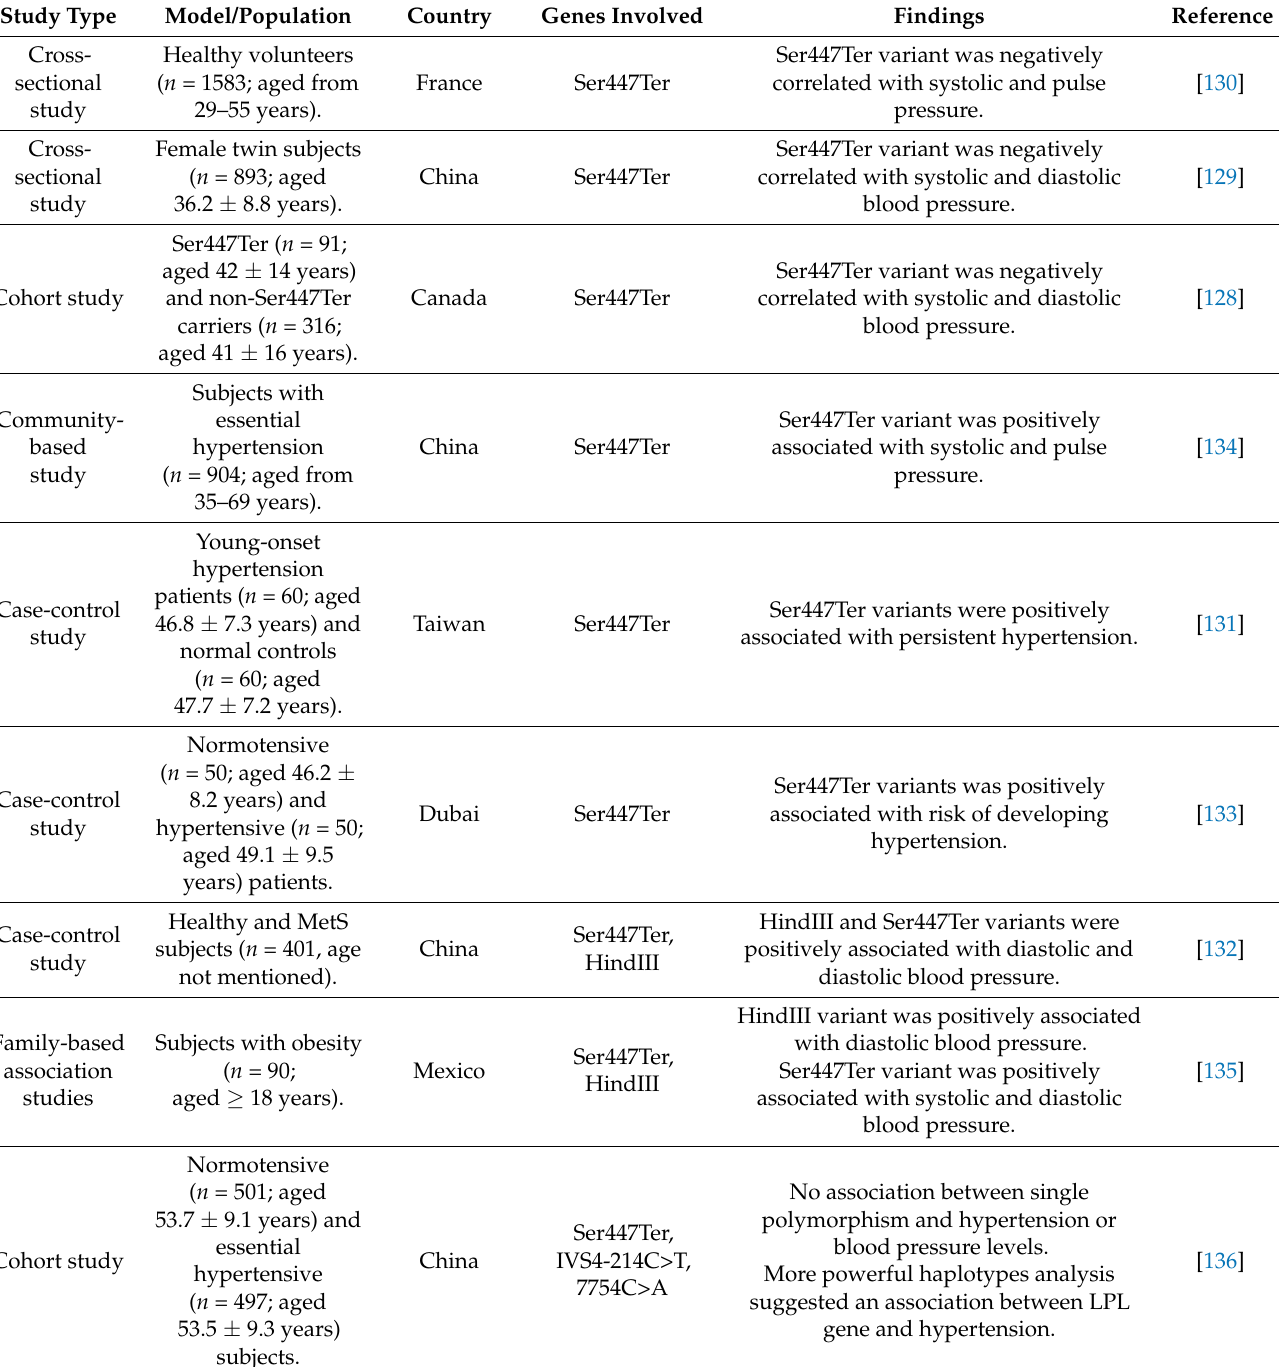
Table 8. The relationship between lipoprotein lipase and blood